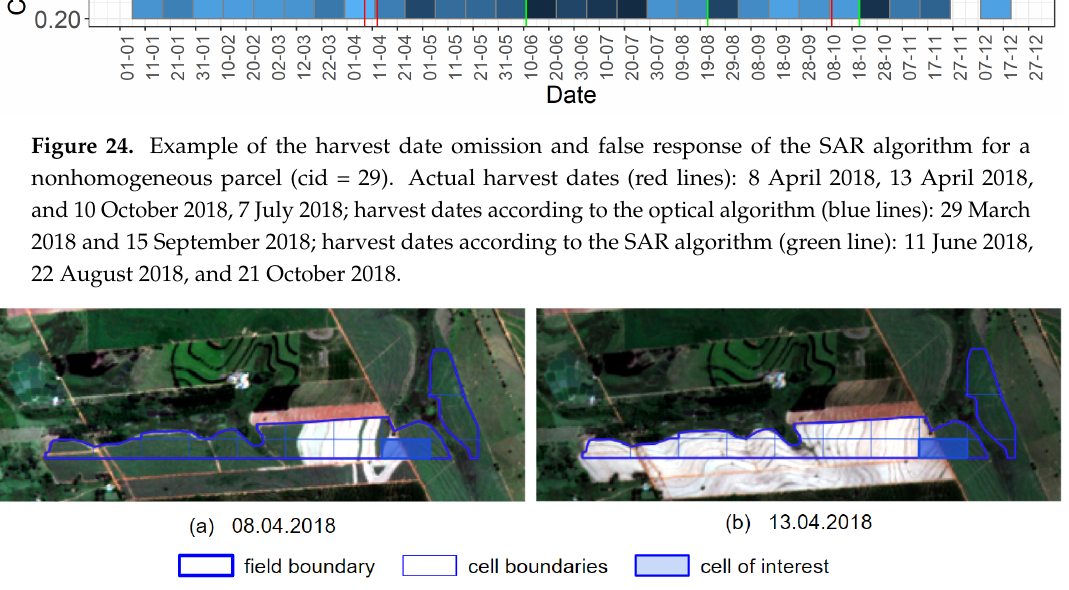
Figure 25. ( a , b ) Example of a nonhomogeneous parcel (cid =